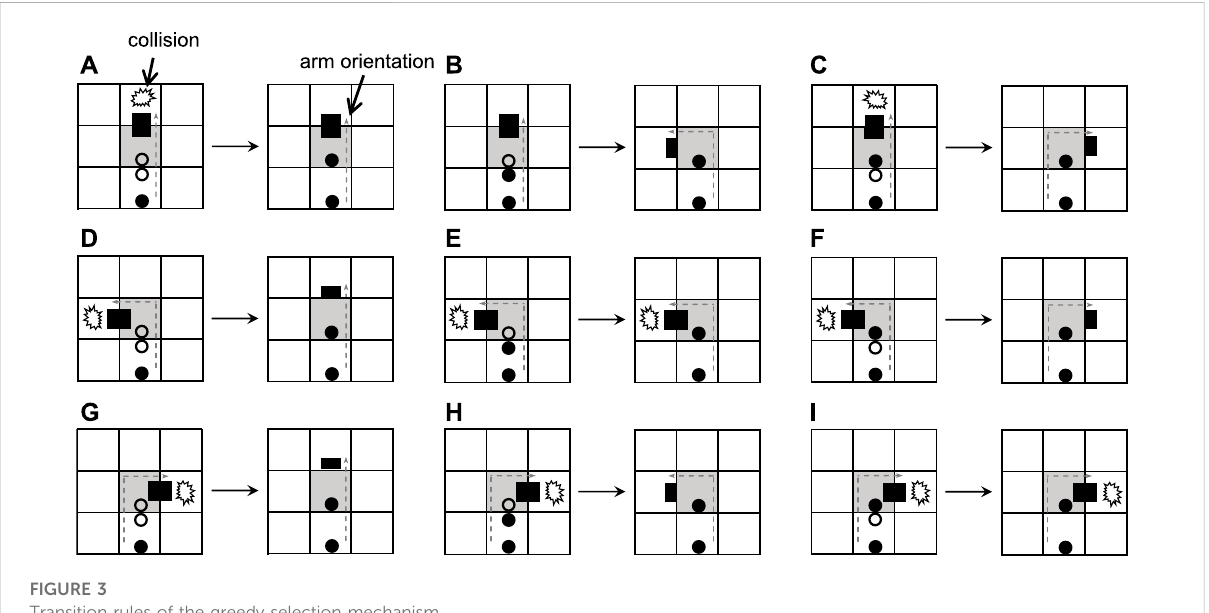
FIGURE 3 Transition rules of the greedy selection mechanism.